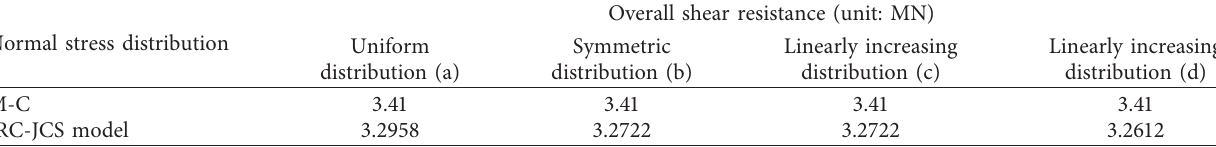
Table 1: Comparison of overall shear resistance of a joint with different normal stress distribution patterns.